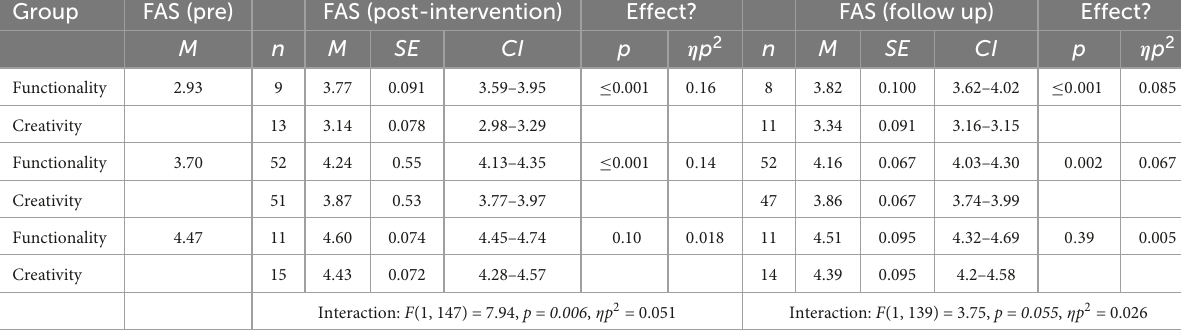
TABLE 5 Summary of completer analysis for functionality appreciation (FAS), including estimated marginal means and effects of the intervention at baseline values of FAS one-standard deviation below the mean, the mean, and one-standard deviation above the mean, as well as the interaction effect (baseline FAS and study arm) on FAS at post-intervention ( n = 151) and 1-month follow up ( n = 143). Group